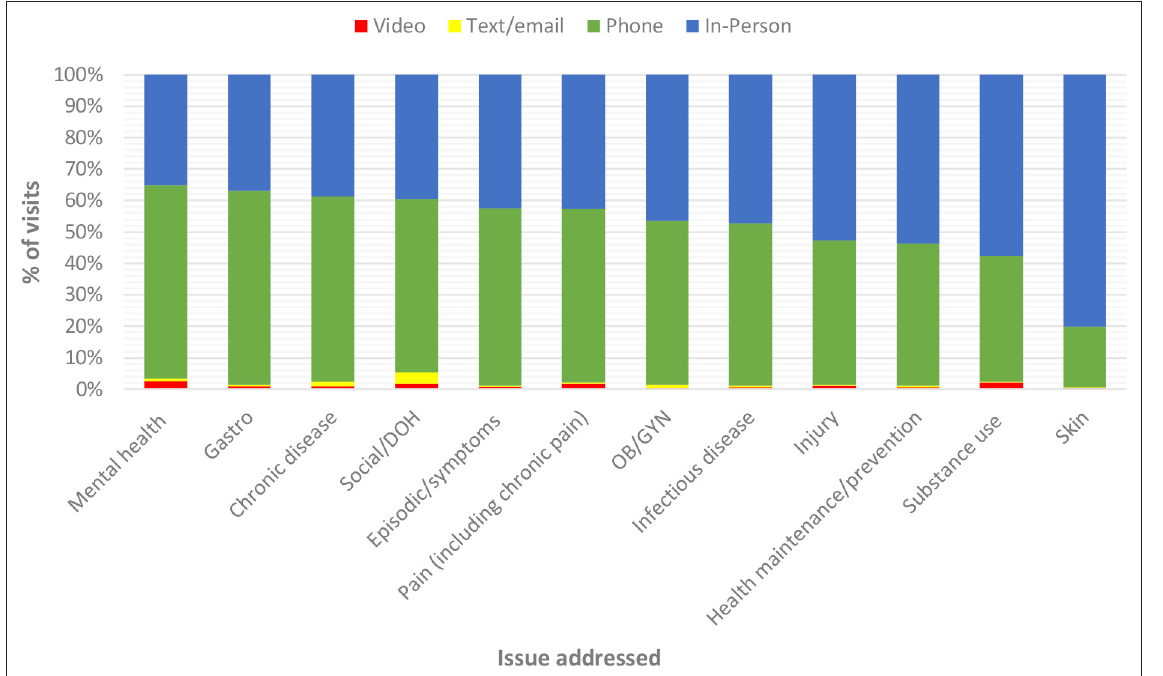
Figure 2 Issues addressed by visit modality during pandemic period, April 2020–February 2021. DOH = determinants of health. OB or GYN = obstetrics or